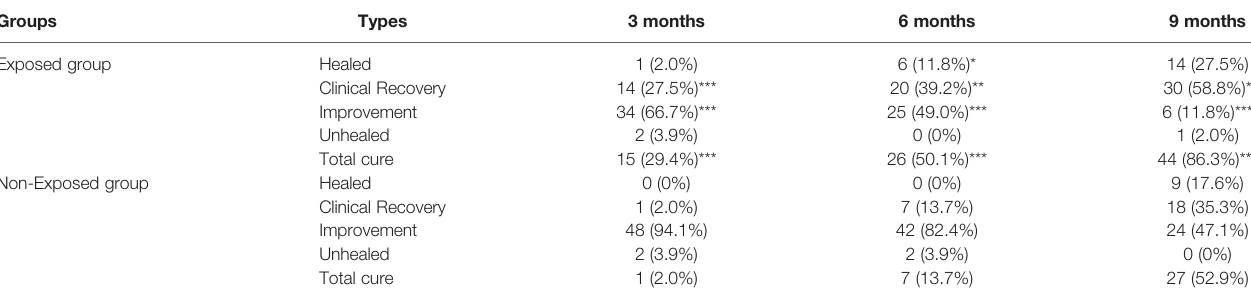
TABLE 2 | Cure cases (rate) between the two groups.